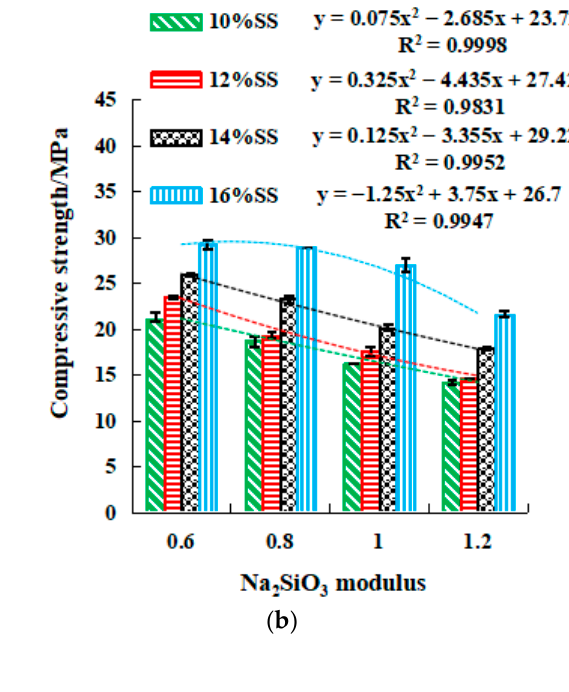
Figure 7. The relationship of setting time and SS dosage. ( a ) Initial setting time. ( b ) Final setting time. y = −ax + b , where y is the setting time, min. x is SS activator dosage, 10 ≤ x ≤ 16%. a and b are constants.